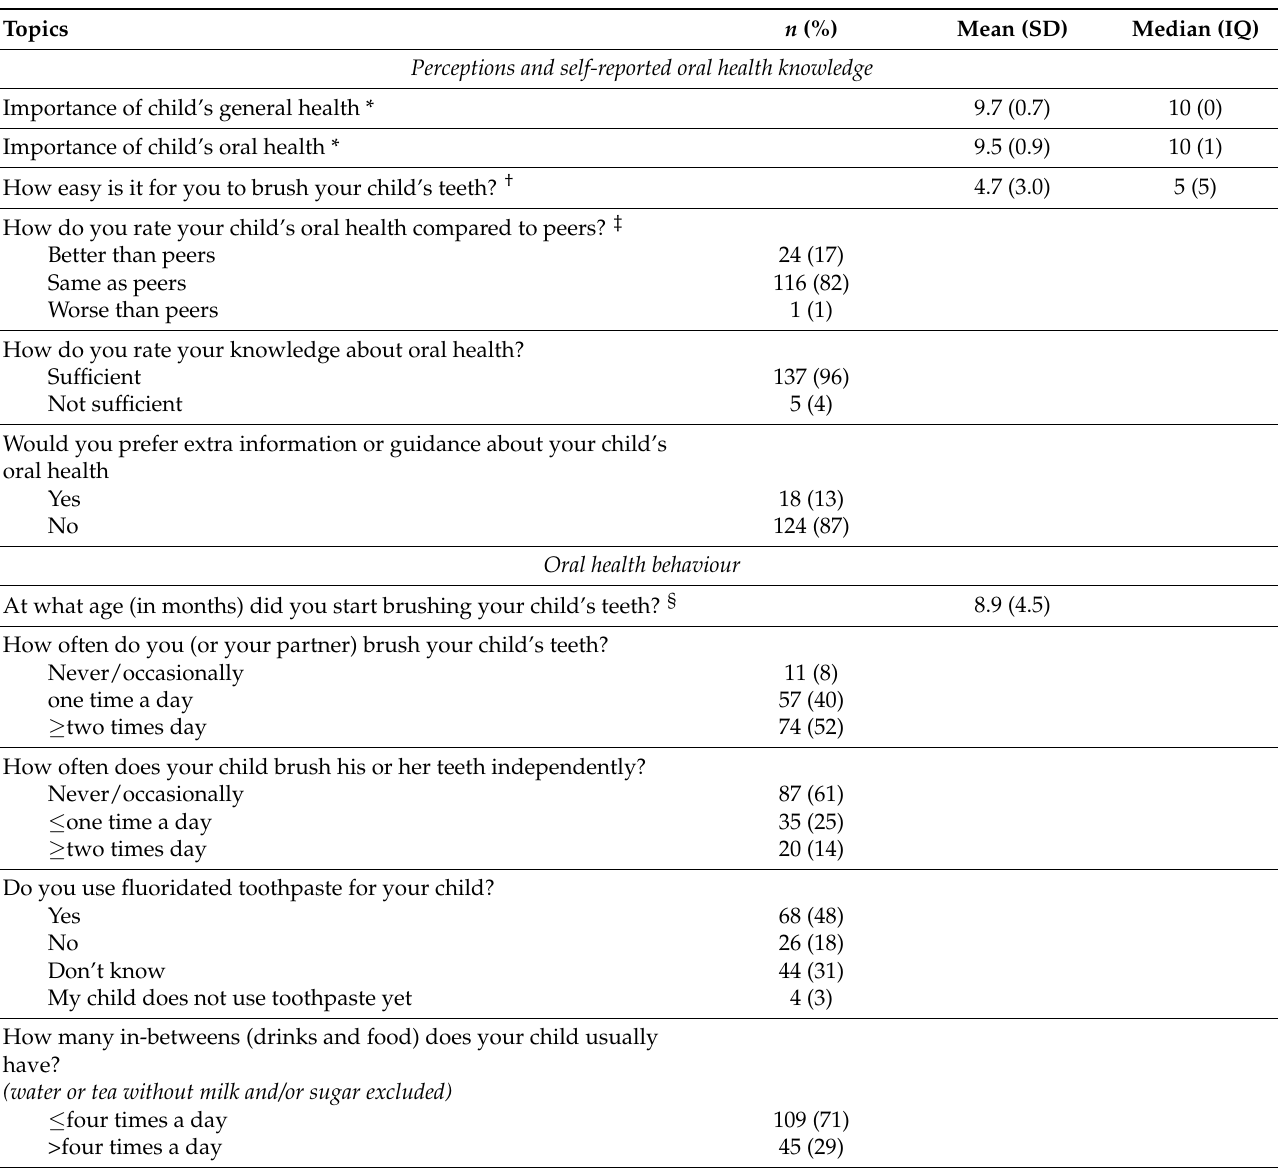
Table 2. Perceptions, knowledge, and oral hygiene